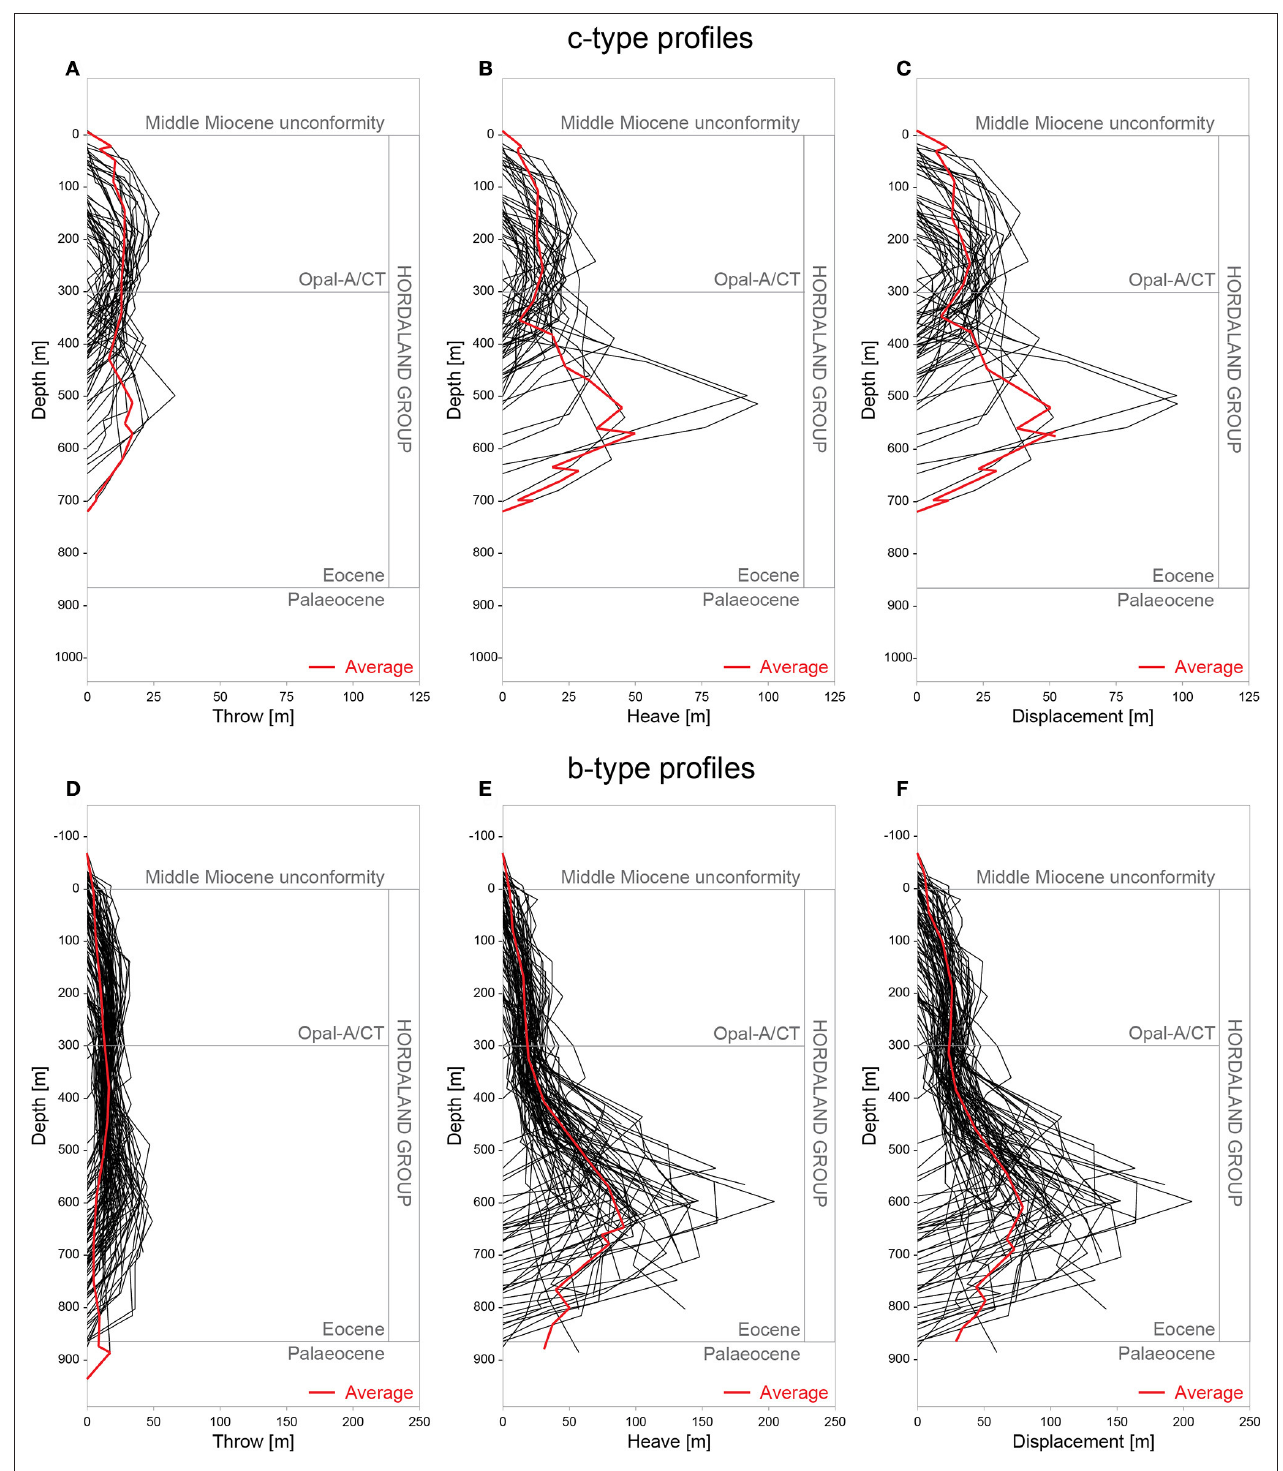
FIGURE 8 | Throw-, heave- and displacement-depth profile of c-type (A–C) and b-type faults (D–F). Note the bulk displacement accumulated in the lower Hordaland Group.